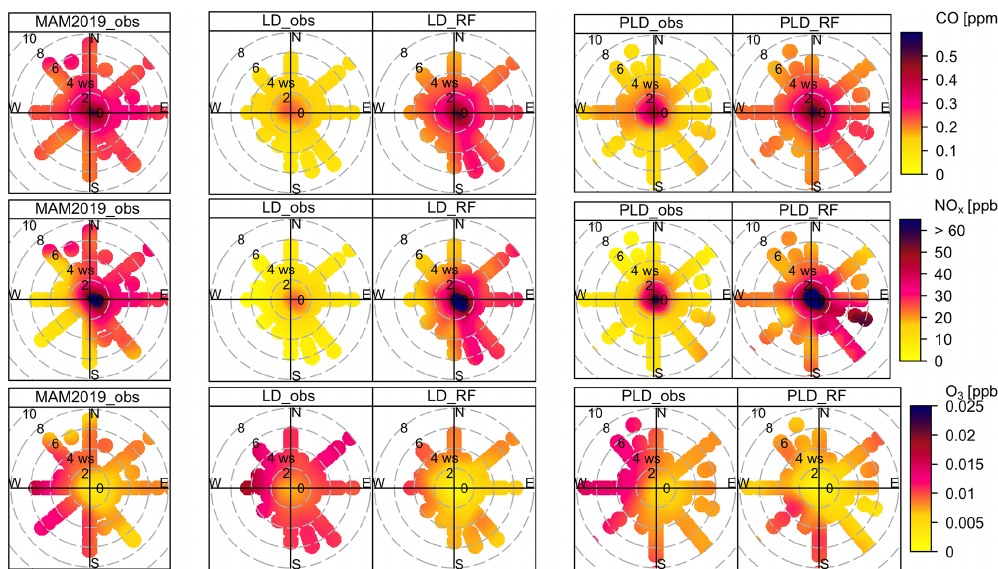
Figure 8. Bivariate polar plot for CNEA of hourly means for observations during MAM2019 and the lockdown periods versus the BAU scenario estimated with the RF model. The radial axis represents wind speed, the angular axis represents wind direction, and the color scale represents pollutant